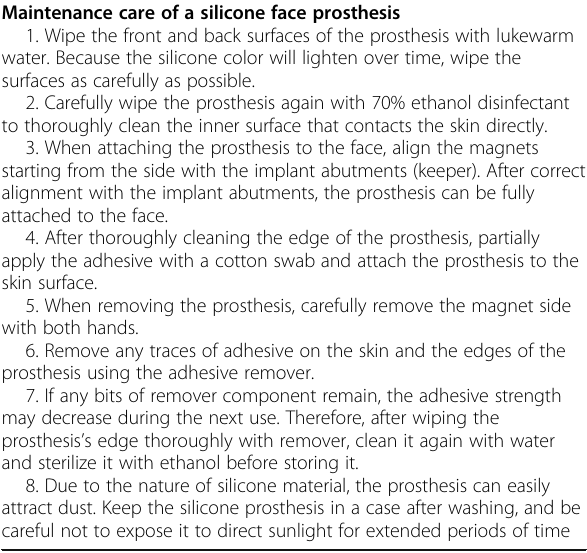
Table 1 Maintenance care instructions for the patient Maintenance care of a silicone face prosthesis 1. Wipe the front and back surfaces of the prosthesis with lukewarm water. Because the silicone color will lighten over time, wipe the surfaces as carefully as possible. 2. Carefully wipe the prosthesis again with 70% ethanol disinfectant to thoroughly clean the inner surface that contacts the skin